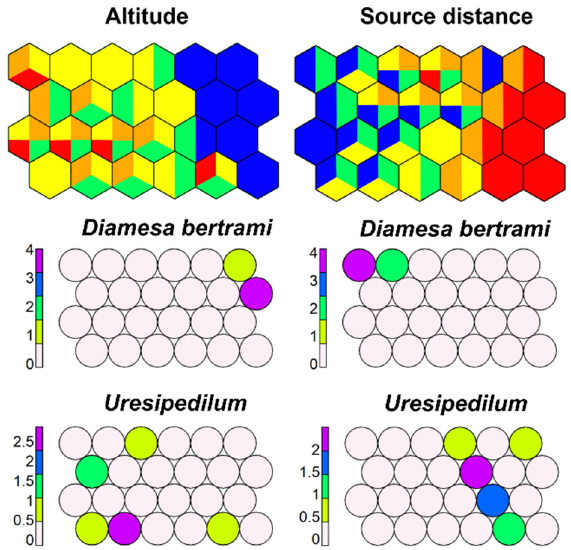
Figure 20. Supervised map of sites and two morphotaxa clustered, respectively, using altitude (in m a.s.l.) and source distance (in km) as external variable. Altitudinal range: Blue, >1000 m;